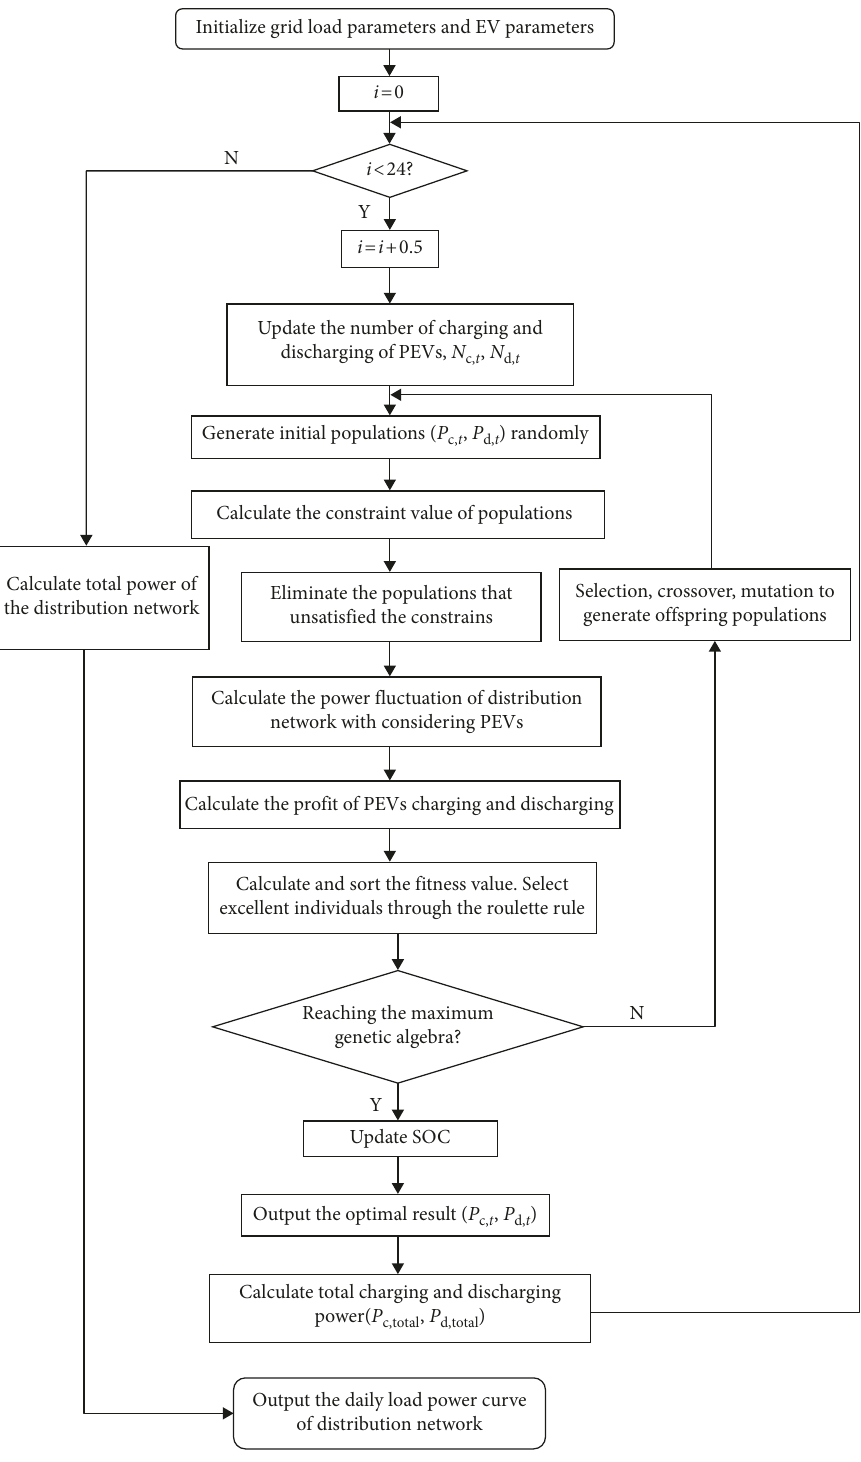
Figure 4: The optimization algorithm flowchart of charging and discharging